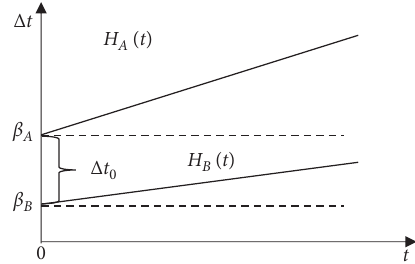
Figure 1: Clock drift models of terminal A and terminal B